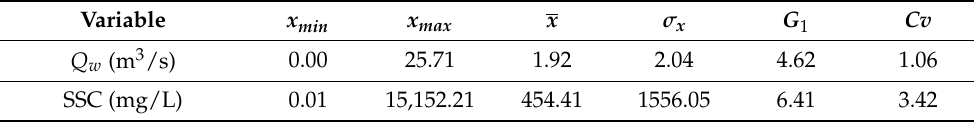
Table 1. Statistical parameters of data for the studied watershed 1 .